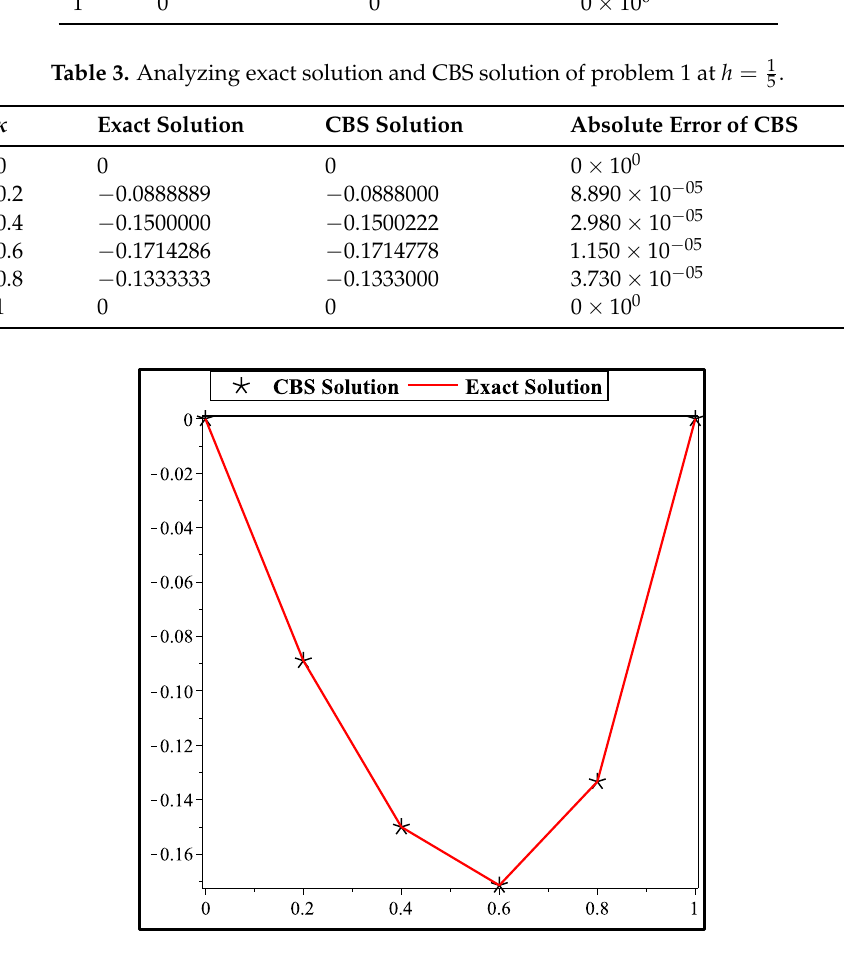
Figure 2. Problem 1 at h = 1